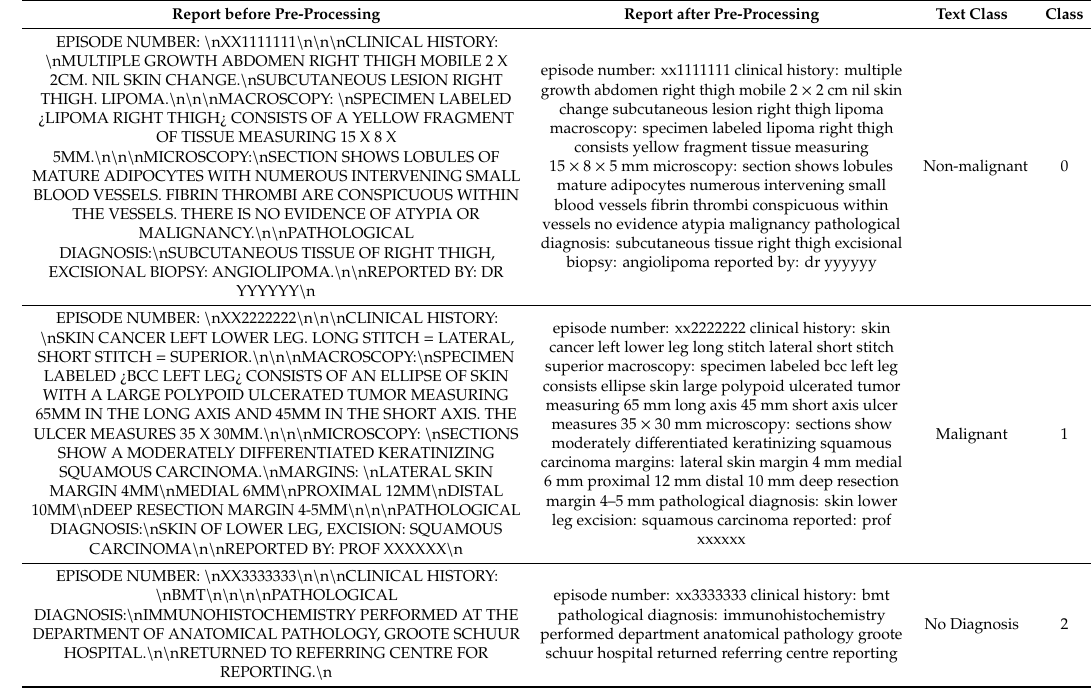
Table 2. Example of the histopathology reports for the three